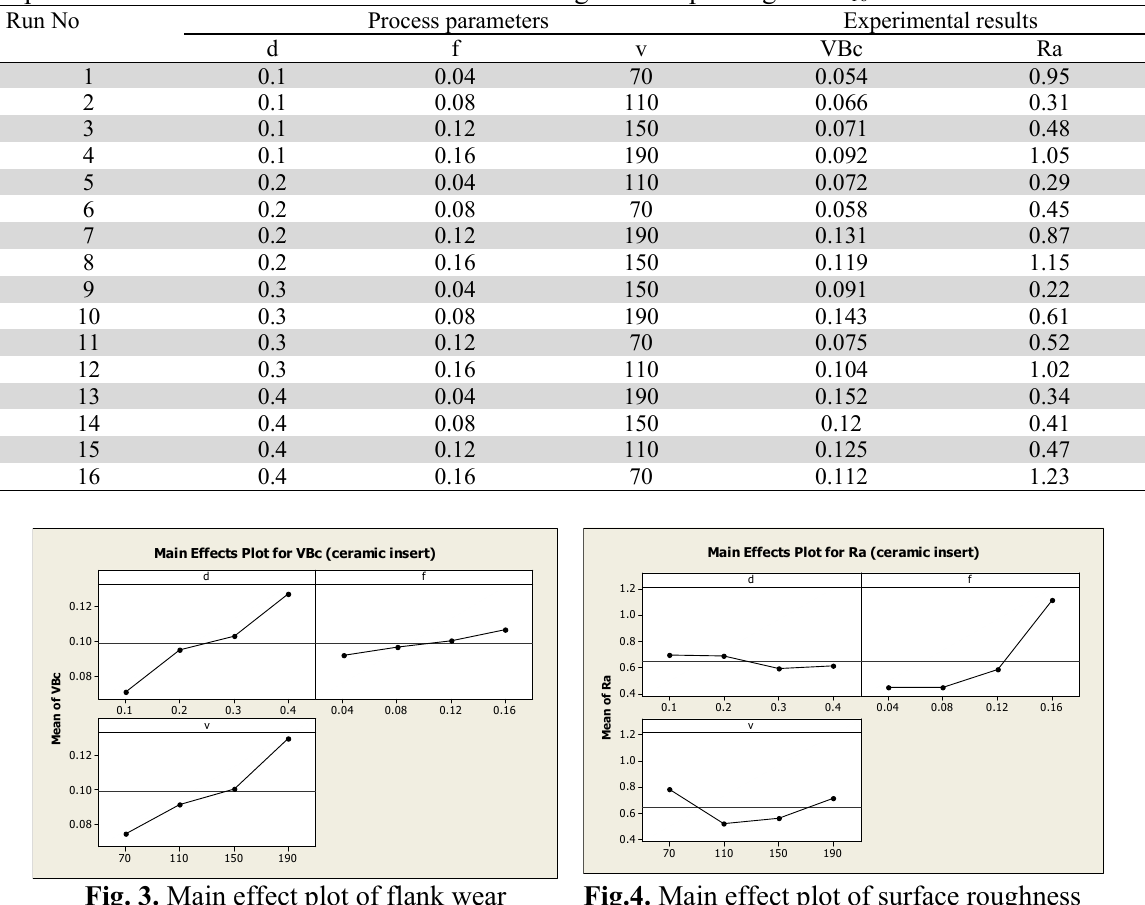
Experimental results for flank wear and surface roughness as per Taguchi L 16 OA Run No Process parameters